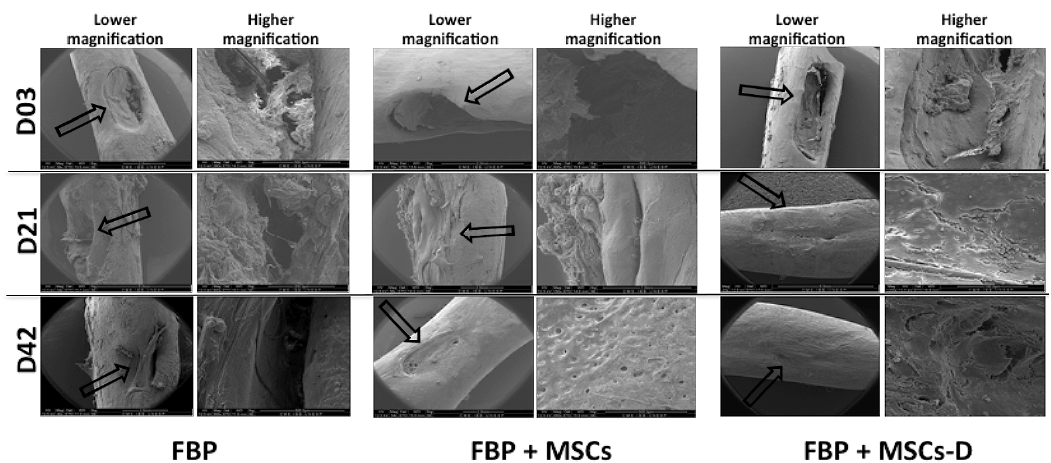
Figure 3. Scanning electron microscopy (SEM) imaging of bone injury in femur of rats at 3 (D03), 21 (D21) and 42 (D42) days post injury. FBP (fibrin biopolymer only); FBP + MSCs (fibrin biopolymer + mesenchymal stem cells); FBP + MSC-D (fibrin biopolymer + differentiated mesenchymal stem cells).